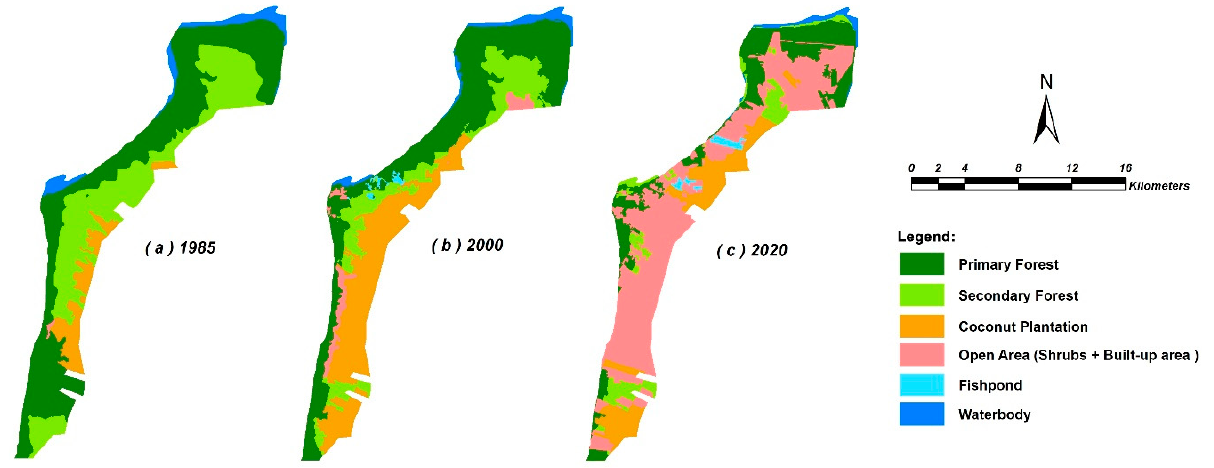
Figure 3. Land cover map in ATPF for ( a ) 1985, ( b ) 2000, and ( c ) 2020.